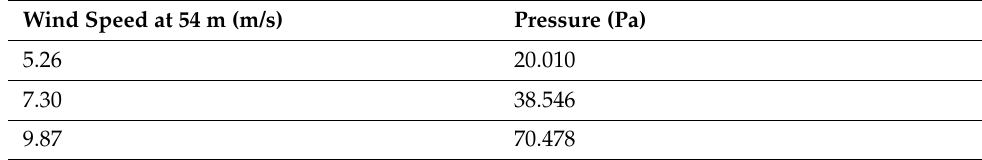
Table 9. Values of pressure according to wind speed.